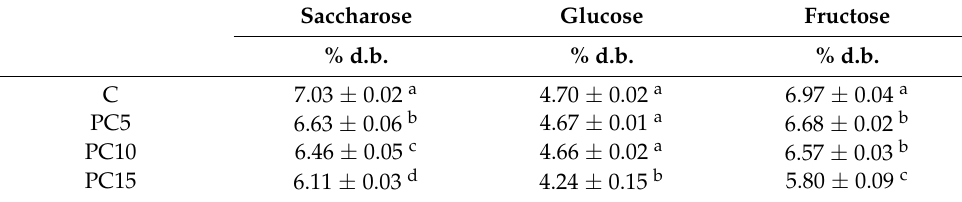
Table 3. The contents of soluble sugars of oatmeal cookies with poppy seed expeller added ( n =